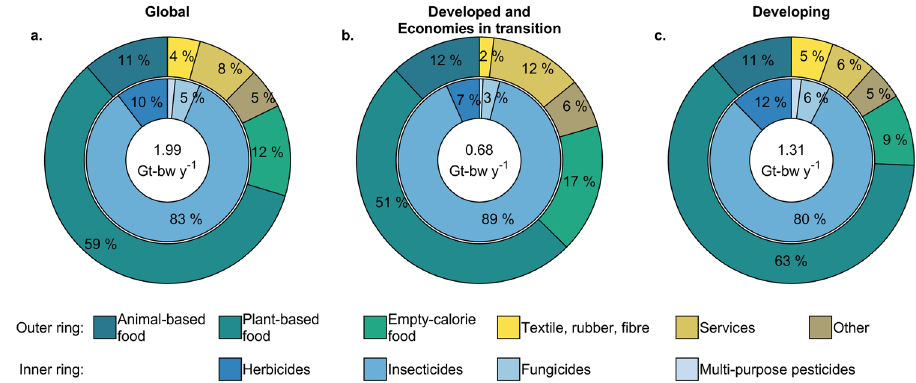
Fig. 1 Pesticide footprints embedded in the world ’ s consumption across different sectors. a – c correspond to the consumption globally, in developed and economies in transition countries, and in developing countries, respectively. The total pesticide footprints include contributions from herbicides, insecticides, fungicides, and multi-purpose pesticides and are expressed as giga tonnes of human body weight per year (Gt-bwy − 1 ). Multi-purpose pesticides refer to pesticides that are used for more than one functions. The footprints embedded in different sectors were analysed using fi nal point of sale to fi nal consumer perspective. Details of region grouping, pesticide classi fi cation, and sector aggregation are provided in Supplementary Tables 1 – 2